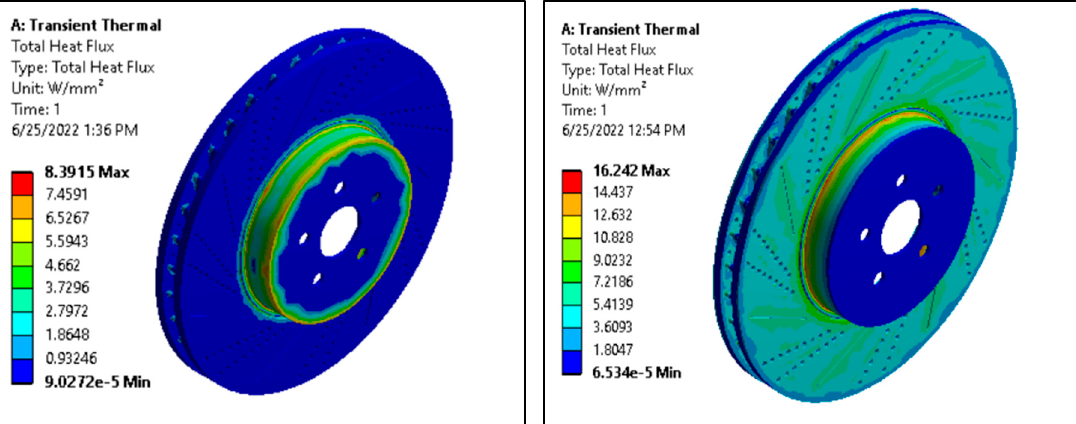
Figure 11. Total heat flux of aluminum alloy and AMNCs disc.